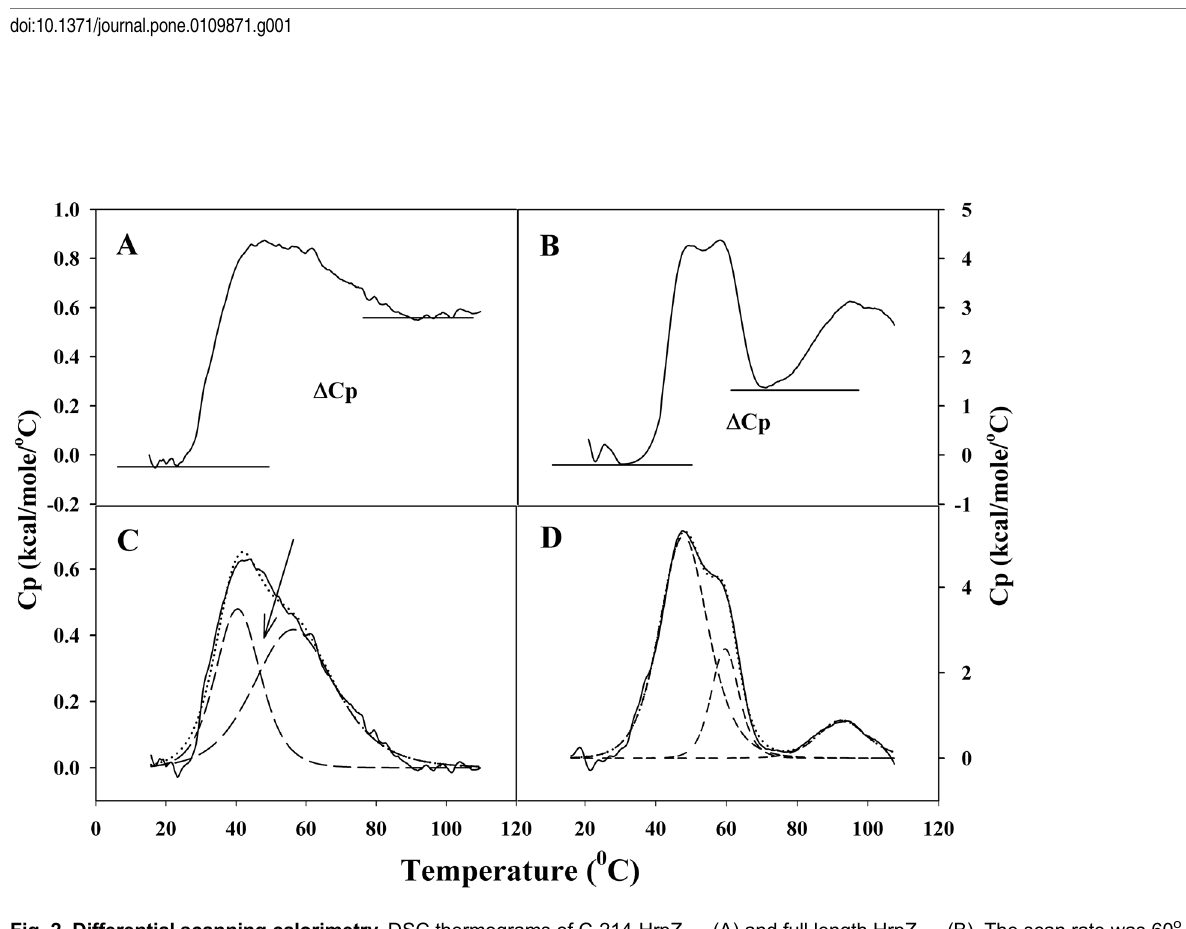
PLOS ONE | DOI:10.1371/journal.pone.0109871 December 12,